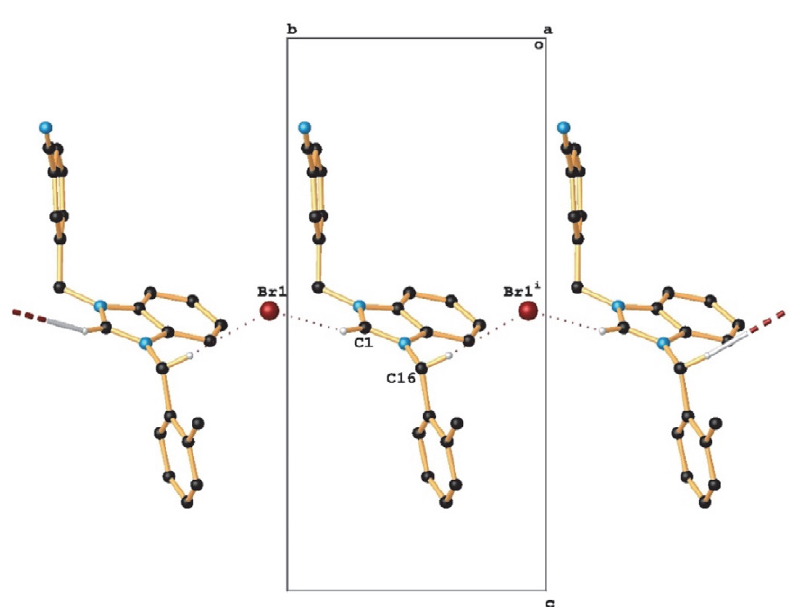
Fig. 2. Packing of the cation molecules of 2b through the intermolecular hydrogen bonds bridged by the bromide anions, which lead to the infinite chain along the b axes. All hydrogen atoms except those participating in the hydrogen bonds were omitted for clarity. Cation molecules are shown in the stick drawing